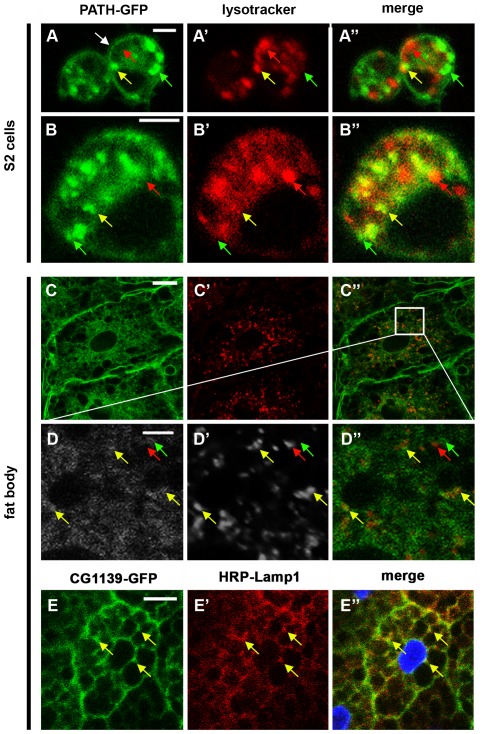

Drosophila PATs are localised at the cell surface and on LEL compartments in vivo.(A, B) Expression of PATH-GFP (green) in living Drosophila S2 cells stained with the acid-sensitive dye Lysotracker Red. Some PATH-GFP is found at the plasma membrane (white arrow), but most is at the surface of intracellular compartments. It does not generally co-localise with the most intensely stained Lysotracker Red-positive compartments (likely to be lysosomes, e.g. red arrows), but does co-localise with the less intensely stained Lysotracker Red-positive compartments (probably late endosomes and some lysosomes, e.g. yellow arrows), perhaps because GFP fluorescence or integrity is affected in highly acidic conditions. In addition, some PATH-GFP-containing compartments do not co-stain with Lysotracker Red (e.g. green arrows). (C, D) PATH-GFP (green) expressed under Lsp2-GAL4 control in the larval fat body also co-localises with only a subset of Lysotracker Red-positive compartments in living tissue (e.g. examples marked with arrows as in A and B), but is also expressed at high levels at the surface of cells. Note in D, PATH-GFP is specifically expressed at the surface of some larger Lysotracker Red-positive structures (yellow arrows) and other membrane structures (green arrows), consistent with its known membrane-association. (E) CG1139-GFP co-localises with many, but not all compartments stained with HRP-Lamp1, a late endosomal and lysosomal marker, in fixed larval fat bodies (e.g. yellow arrows), suggesting that some, but not all, intracellular CG1139 is in LELs. Nuclei are stained with DAPI (blue) in E″. Scale bar is 5 µm in A, B and D, and 20 µm in C and E.